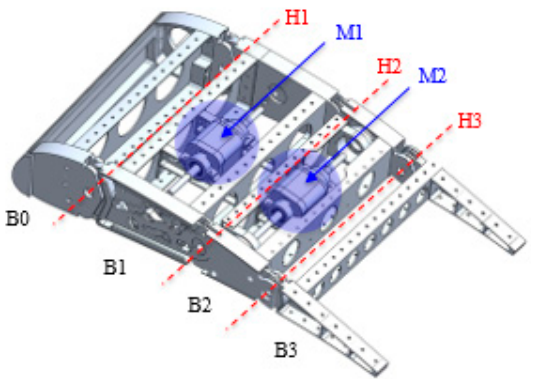
Figure 3. Actuated morphing bay.